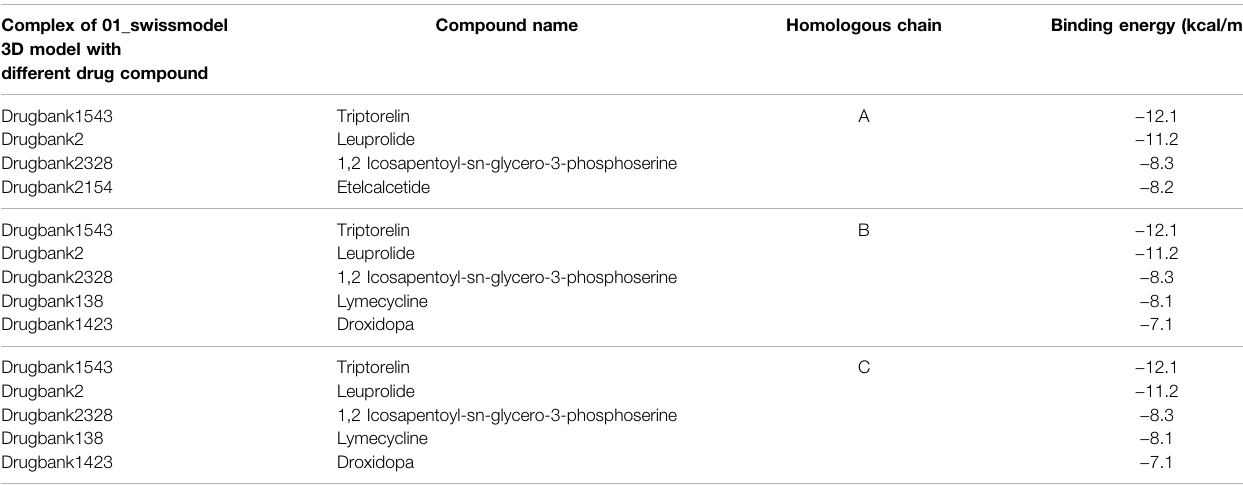
TABLE 4 | Protein – ligand complexes that met the binding energy threshold with respect to the different chains of the protein. Complex of 01_swissmodel 3D model with different drug